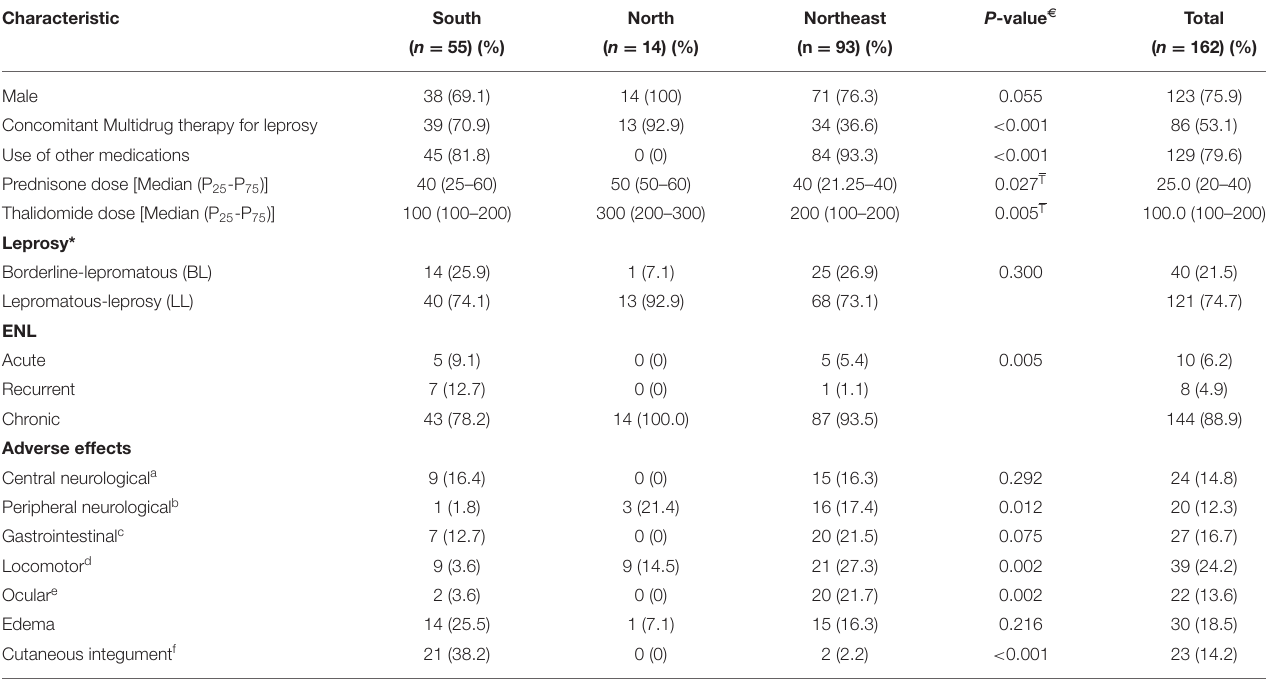
TABLE 1 | Clinical and demographic characteristics of ENL